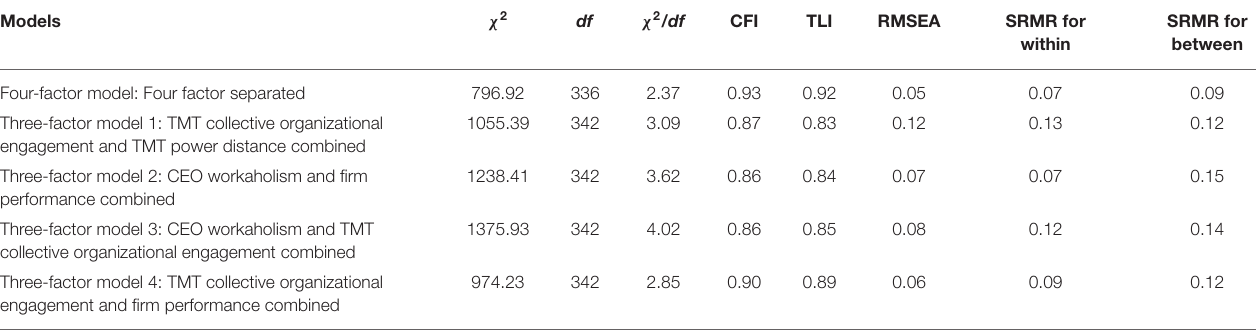
TABLE 2 | Means, standard deviations, and correlations.